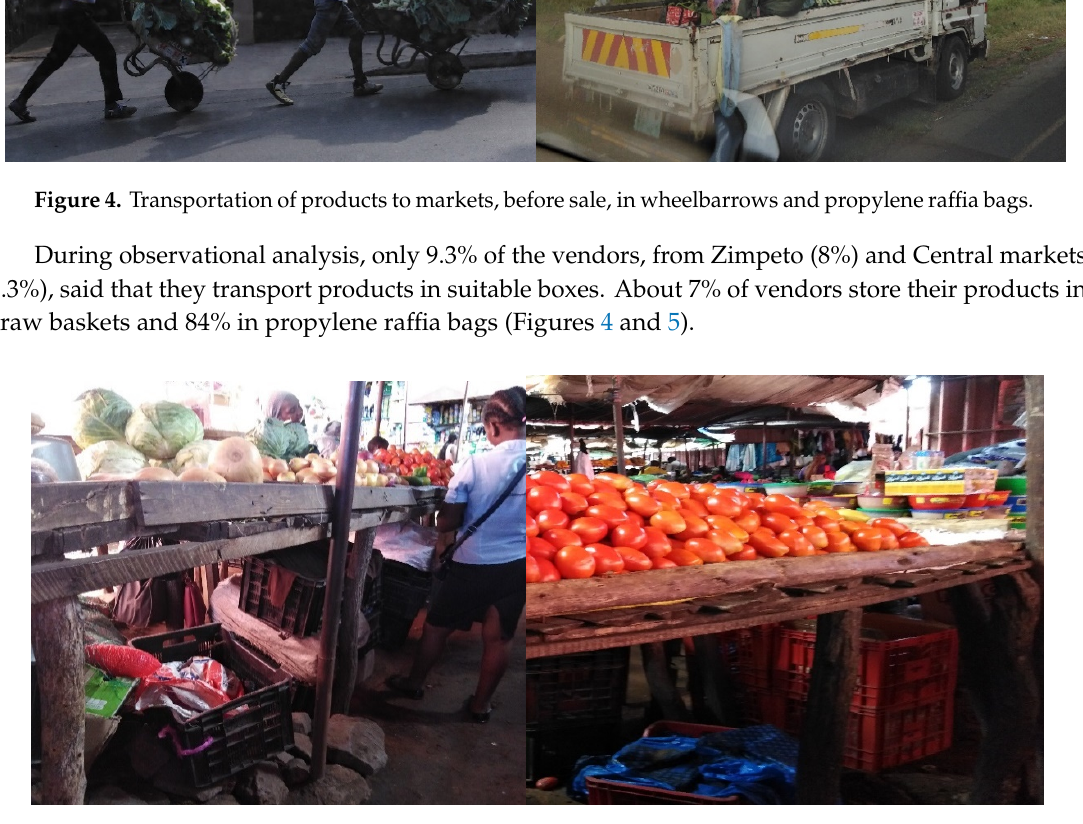
Figure 5. Storage of products below their stands at market in plastic bags and plastic boxes on Fajardo’s market.